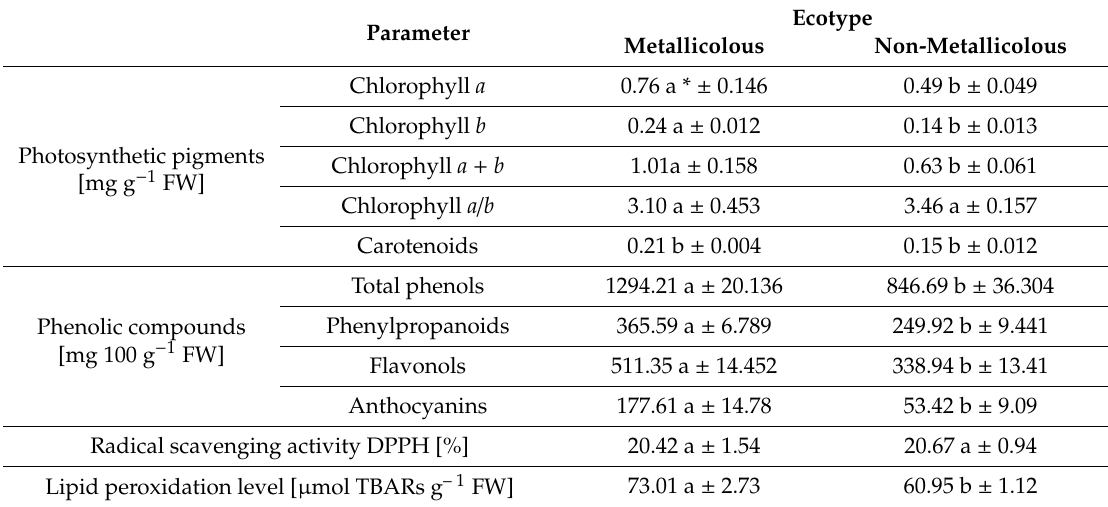
Table 3. Photosynthetic pigments’ content, phenolic profile as well as radical scavenging activity and lipid peroxidation in leaves of Anthyllis vulneraria